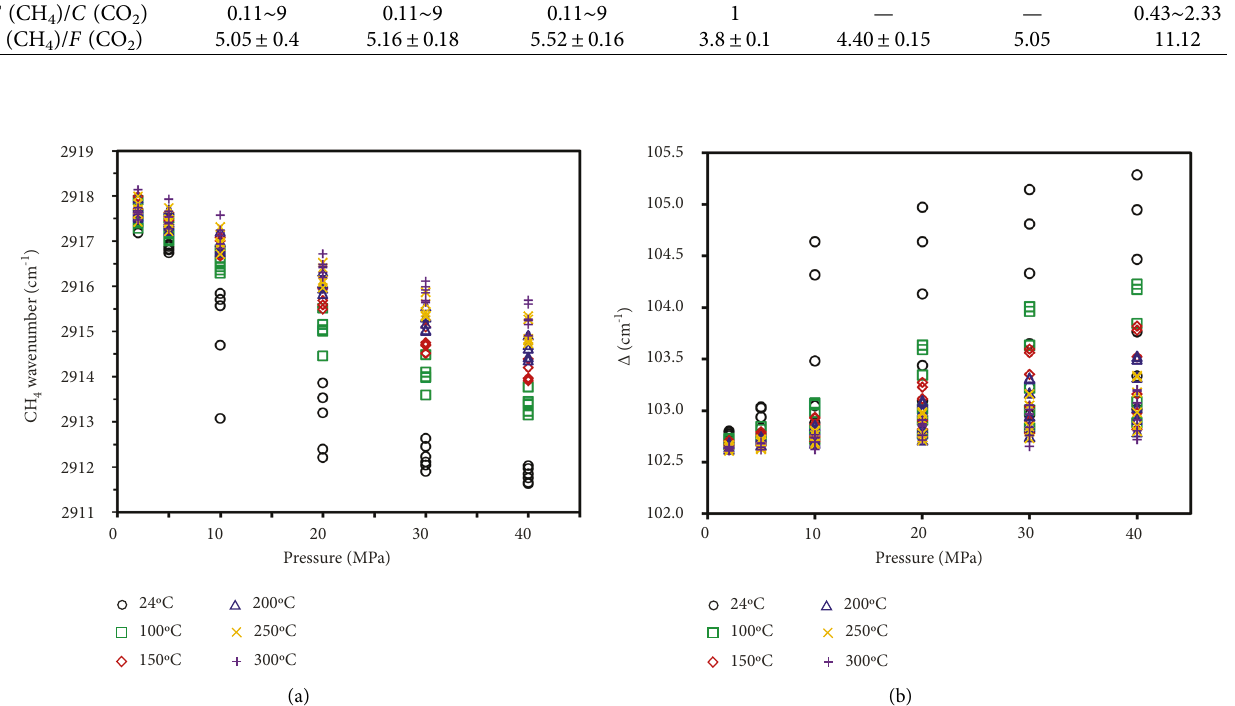
Figure 8: Effect of temperature on the Raman peak positions of (a) the υ CH 4 gas mixtures as a function of pressure.